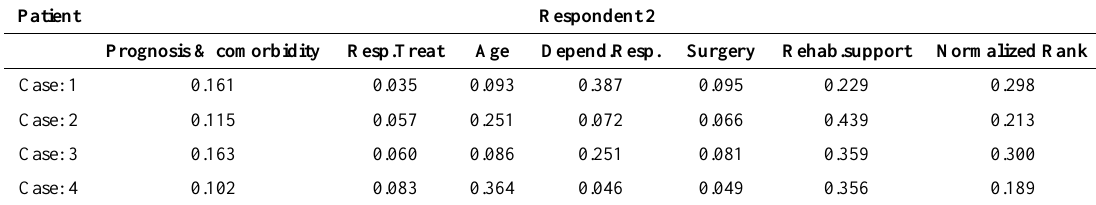
Table 16. Patient Rank with the Multi-Factor Triage Algorithm, (MUFTA) (Expert 2)